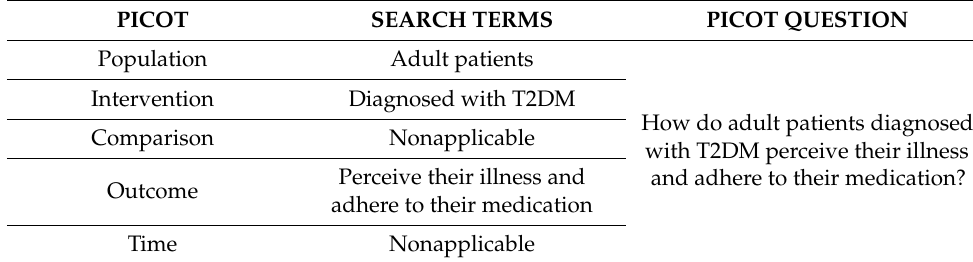
Table 1. Framing Research Question with PICOT Framework.